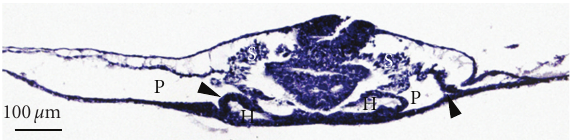
Figure 14: Section through heart region of an embryo after 40 hours of culture of an unincubated blastoderm operated on as represented in Figure 13(a). In the unoperated side (left side of the photograph), a normal far extending hemi-pericardial cavity (P) is seen with normal epimyocard (arrowhead). At the operated side, the hemi-pericardial cavity (P) is closed (upwards directed arrowhead) and no blood islands are formed peripherally. S, somite-like material; H, bilaterally formed primary heart tubes. Bar = 100 μ